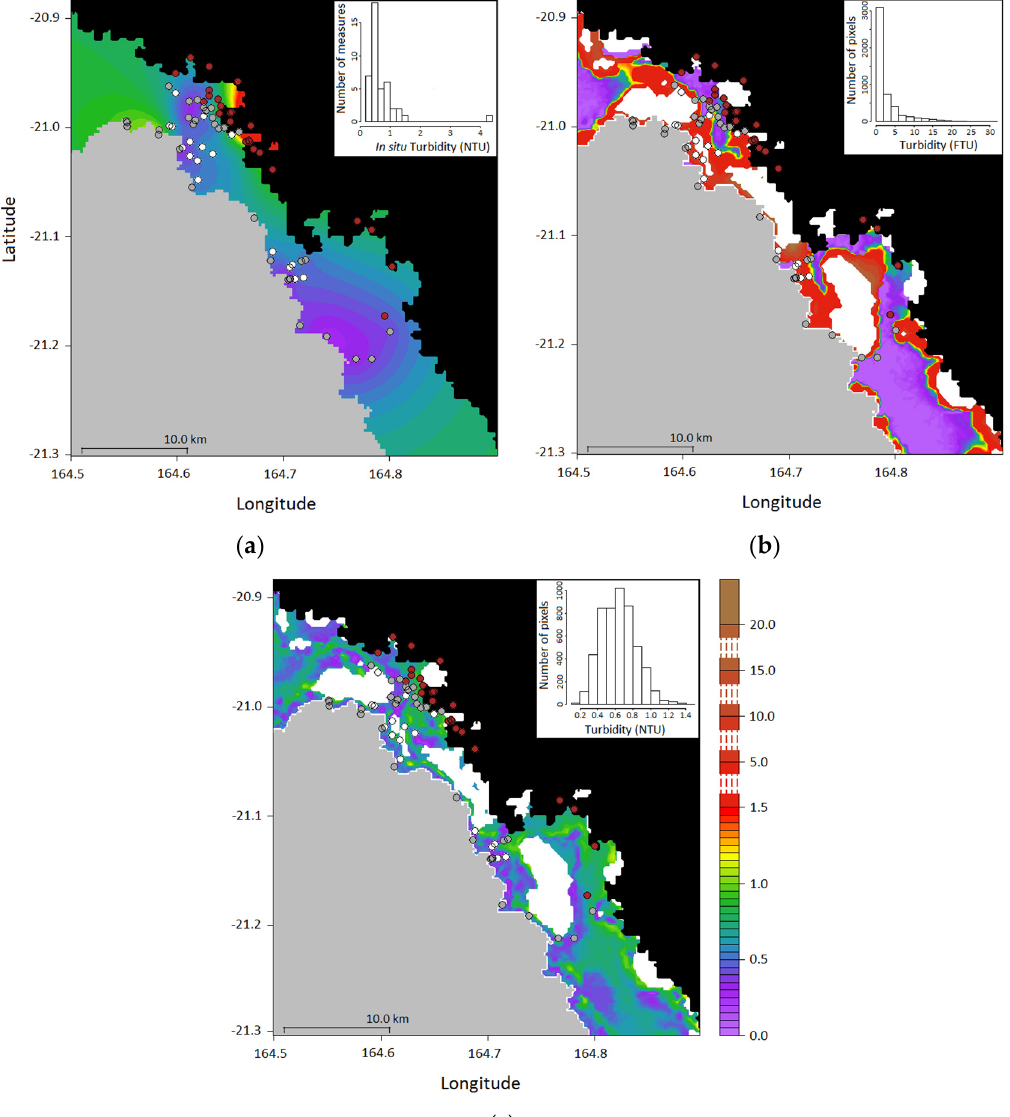
Figure 7. Turbidity in the VKP lagoon area on 24 June 2014. ( a ) in-situ turbidity values (in NTU) interpolated by ordinary kriging and their histogram, as measured with the CTD; ( b ) Map and histogram of turbidity (in FTU) retrieved from the MODIS image with the O2008 model; ( c ) Map and histogram of the turbidity values (in NTU) retrieved from the MODIS image with our B.O.M. Black areas correspond to MODIS land mask and grey areas correspond to deep ocean. Points colours correspond to bottom colour, i.e. : white bottom; : grey bottom; : brown bottom. On maps ( b ) and ( c ) the white areas correspond to flagged pixels.